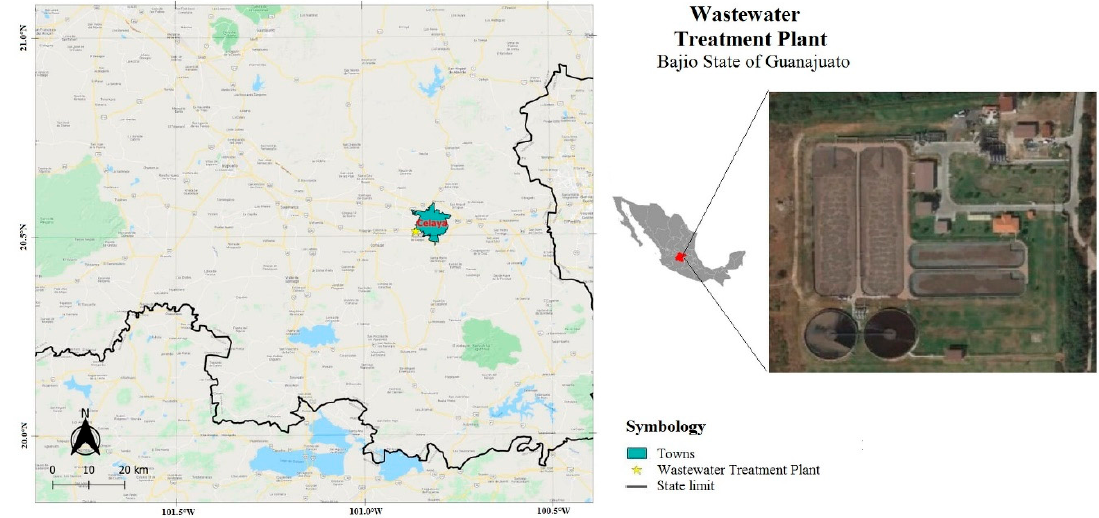
Figure 1. Location map of the urban wastewater treatment plant of the municipality of Celaya, Guanajuato, Mexico with geographical coordinates 100°51 ′ 64 ′′ W and 20°30 ′ 78 ′′ N.